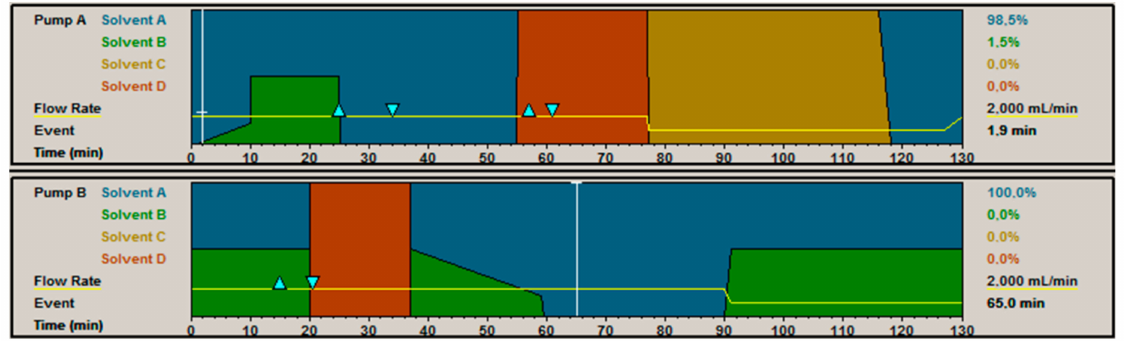
Figure 21. Method for an iCCC cycle. Solvent A is Bu ff er A, Solvent B is Bu ff er B, Solvent C is feed, and Solvent D is the recycle of the fractions. The triangle marks the addition of Bu ff er A into the IEX fraction and Bu ff er B into the HIC fraction.